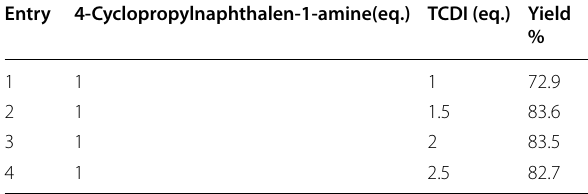
Table 2 Optimization of reaction